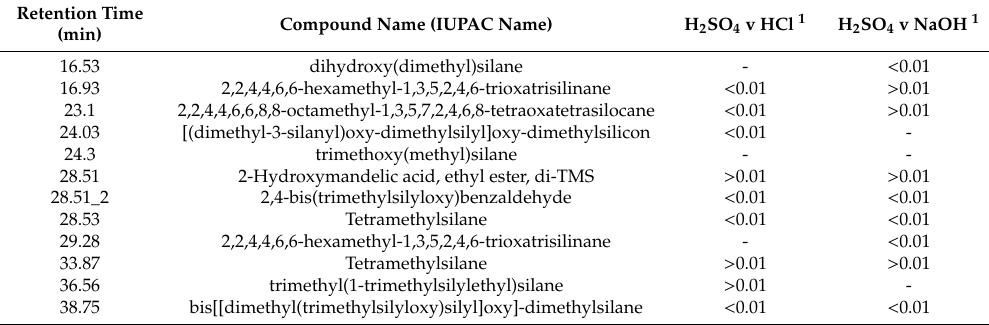
Figure 2. Headspace-solid phase microextraction gas chromatography-mass spectrometry (HS-SPME-GC-MS) degradation across 5 M H 2 SO 4 (red), 5 M HCl (green), and 5 M NaOH (blue) treatment techniques (to generate sample solutions of 0.83 M; pH 0.075, pH 0.081, and pH 13.919, respectively). Box plots show the abundances of identified contaminants per treatment technique. Compounds of degradation are based on their retention times. Table 1. HS-SPME-GC-MS degradation relating retention time to its IUPAC name.